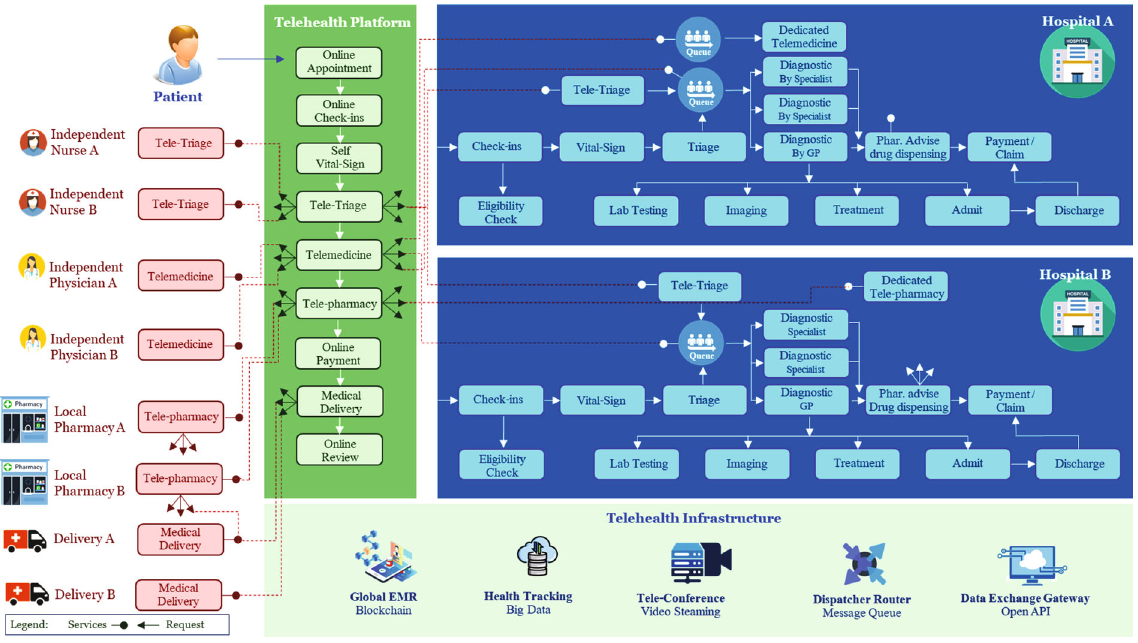
Figure 6: Infrastructure design for a large-scale telehealth